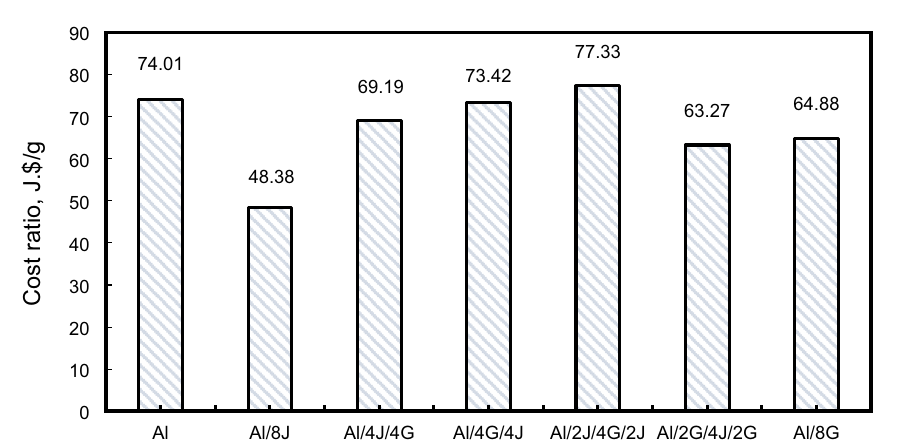
Figure 17. SEM for failed specimens.